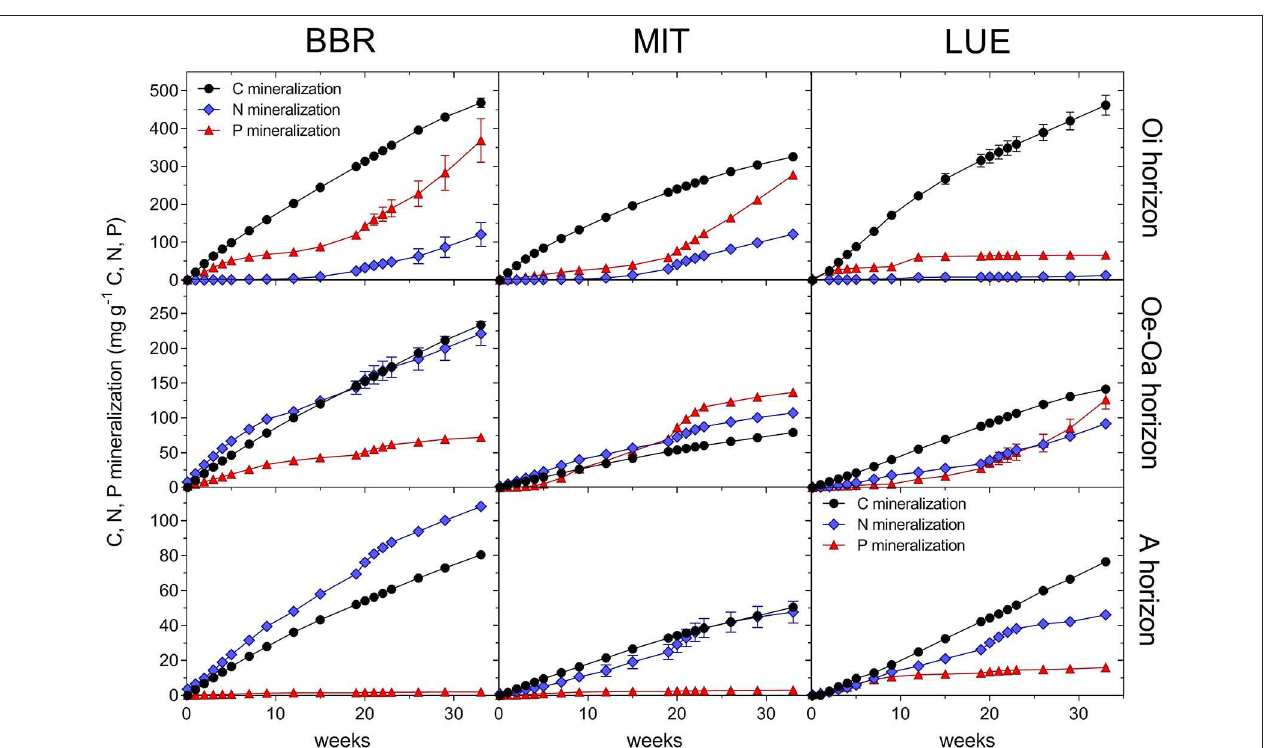
FIGURE 2 | Cumulative net mineralization rates of C, N, and P from the Oi, Oe-Oa, and A horizons from the nutrient-rich site Bad Brückenau (BBR), the intermediate site Mitterfels (MIT) and the nutrient-poor sandy site Luess (LUE). Means and standard errors of four replicates in the permanent moist control